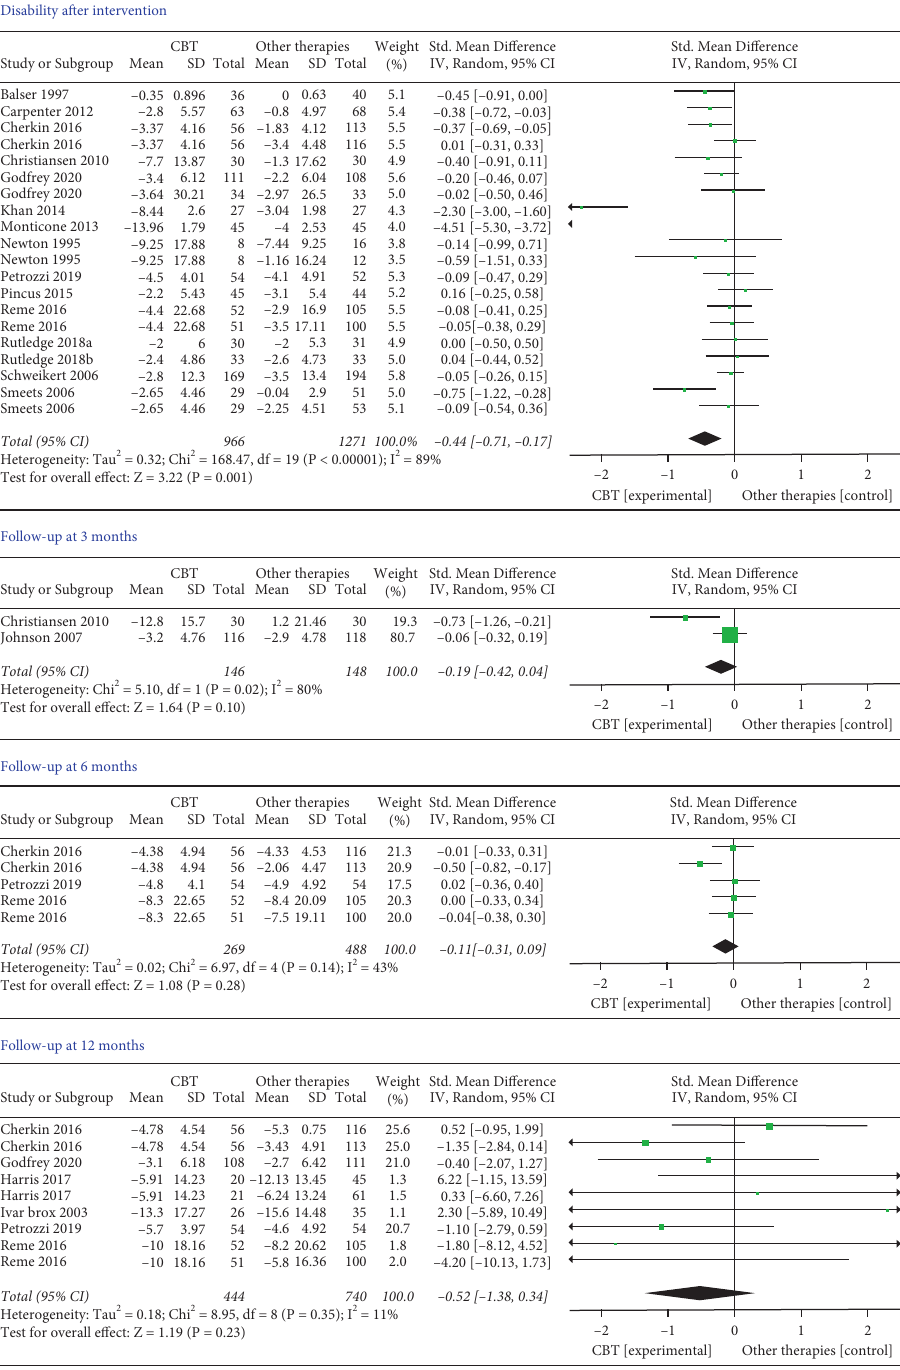
Figure 4: Disability levels immediately after intervention and during the follow-up period. Compared with other therapies, the overall effect of CBT on disability outcome immediately after intervention was significant ( P < 0 . 05). All the follow-up periods failed to show statistical